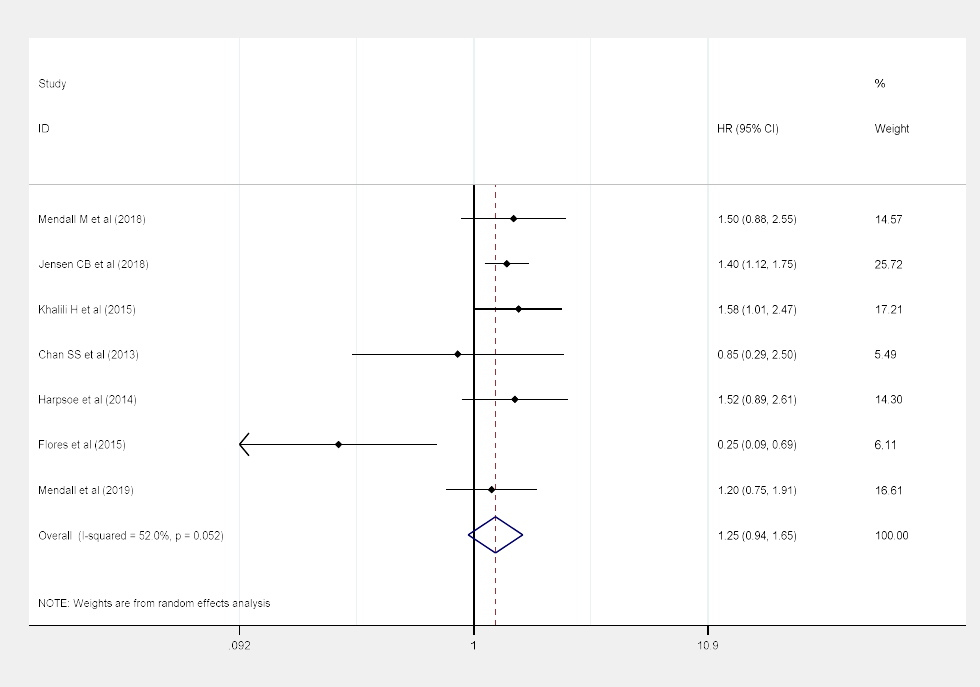
Figure 4. Association between obesity (BMI ≥30 kg/m 2 ) and risk of Crohn’s disease.